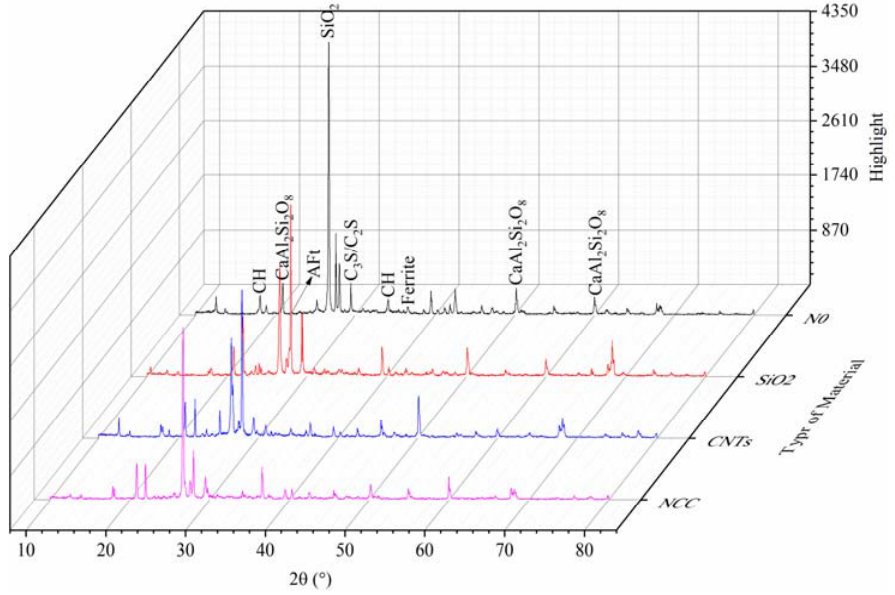
Figure 6. X ‐ ray diffraction patterns at 28 d of age. Figure 6. X -ray di ff raction patterns at 28 d of age.